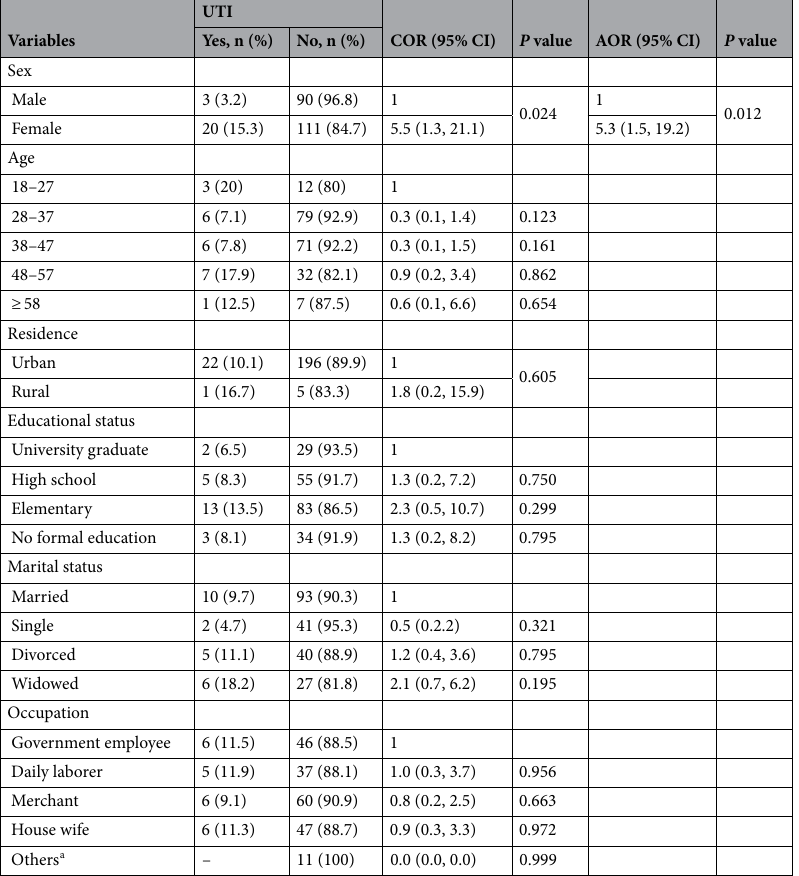
Table 2. Bivariate and multivariate analysis of sociodemographic characteristics and UTI among people living with HIV who were attending Hawassa University Comprehensive Specialized Hospital ART clinic, Hawassa, Ethiopia, from September 17 to November 16, 2018 (n = 224). UTI urinary tract infection, COR crude odd ration, AOR adjusted odd ratio, CI confidence interval, n number. a Others: driver, student and